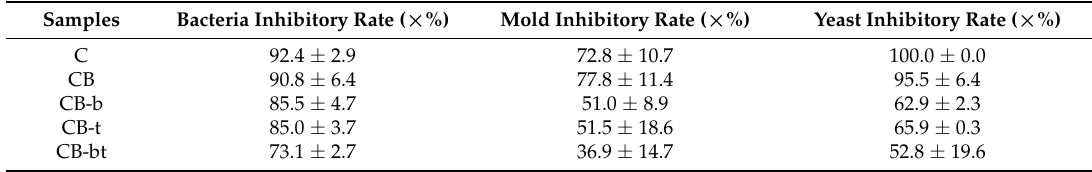
Table 3. A comparison of antimicrobial activity of C, CB, CB-b, CB-t, and CB-bt against E. coli , B. cinerea , and S. cerevisiae